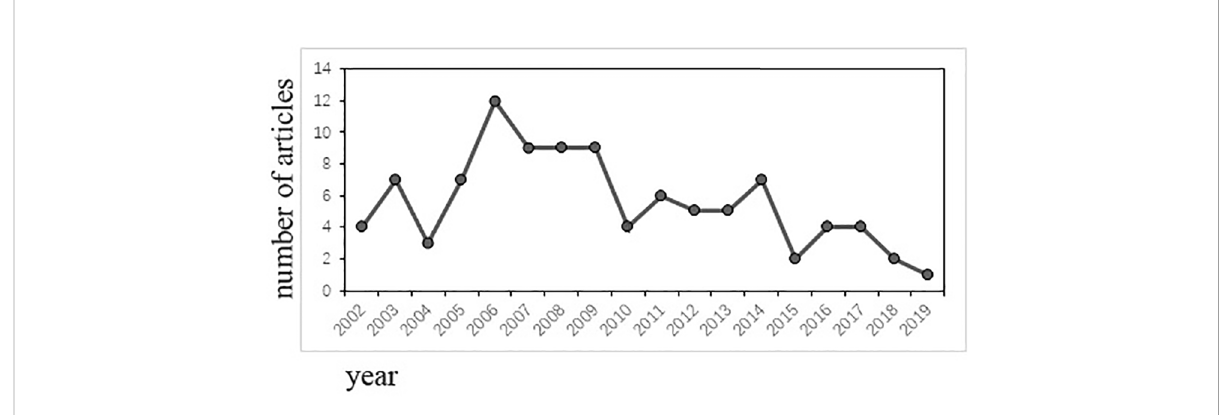
FIGURE 1 The number of articles published each year.